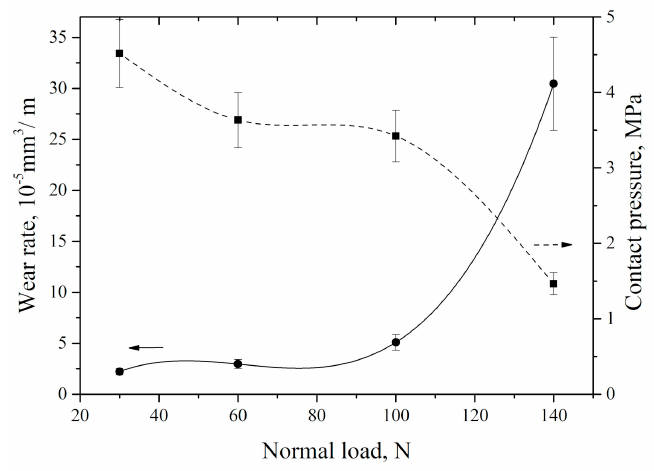
Figure 7. Neat UHMWPE wear rate vs. specific pressure on the wear track at different loads.